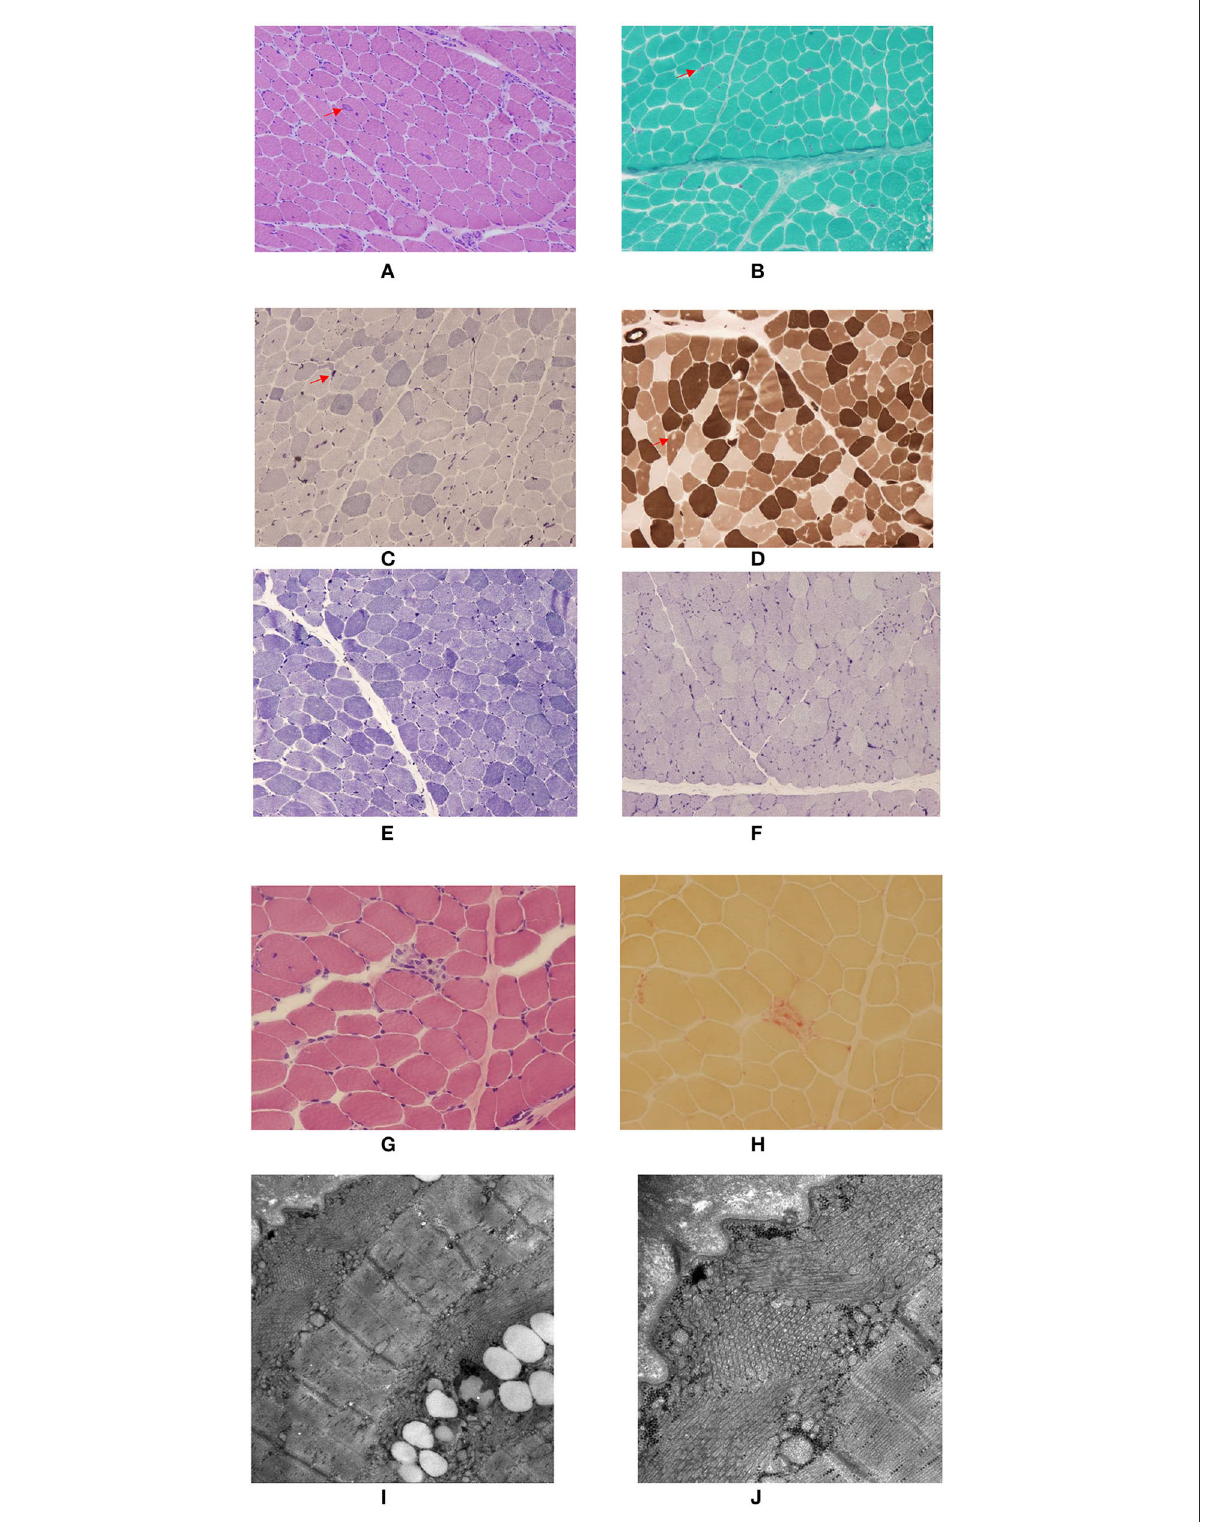
FIGURE2 Myopathological findings of the patients with three GFPT1-related CMS from southwestern China. (A – D) Remarkable large and small tubular aggregates (TAs) (arrow head) located in both the subsarcolommal and inner cytoplasmic regions in patient 1. (A) H&E; (B) , Modified Gomori trichrome stain; (C) NADH-TR stain; (D) ATPase stain at pH 4.7 revealing the negatively stained TAs predominantly located in type 2 fibers. (E,F) Many small TAs located in both the subsarcolemmal and inner cytoplasmic regions in patient 2. (E) NADH-TR stain; (F) AMP stain. (G,H) A few TAs located in the subsarcolemmal region and focal fiber necrosis in patient 3. (G) H&E; (H) acid phosphatase stain. (I,J) Electron microscopy images of TAs in patient 1 and patient 2. (I) TAs located both beneath the sarcolemma and in the inner cytoplasmic region. (J) TAs in both transverse and longitudinal